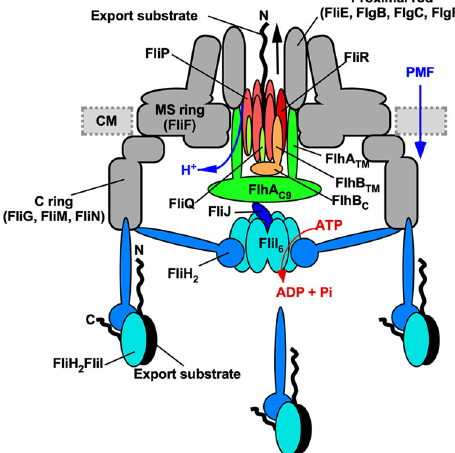
Fig. 1 Schematic diagram of the fl agellar protein export apparatus. The fl agellar protein export apparatus is composed of a transmembrane export gate complex made of FlhA, FlhB, FliP, FliQ, and FliR and a cytoplasmic ATPase ring complex consisting of FliH, FliI, and FliJ. The export gate complex is located inside the MS ring and utilizes proton motive force (PMF) across the cytoplasmic membrane (CM) to drive proton (H + )- coupled fl agellar protein export. FliP, FliQ, and FliR form a polypeptide channel complex. The N-terminal transmembrane domain of FlhB (FlhB TM ) associates with the FliP/FliQ/FliR complex, and its C-terminal cytoplasmic domain (FlhB C ) projects into the central cavity of the C ring. FlhA forms a homo-nonamer through interactions between the C-terminal cytoplasmic domain of FlhA (FlhA C ), and its N-terminal transmembrane domain